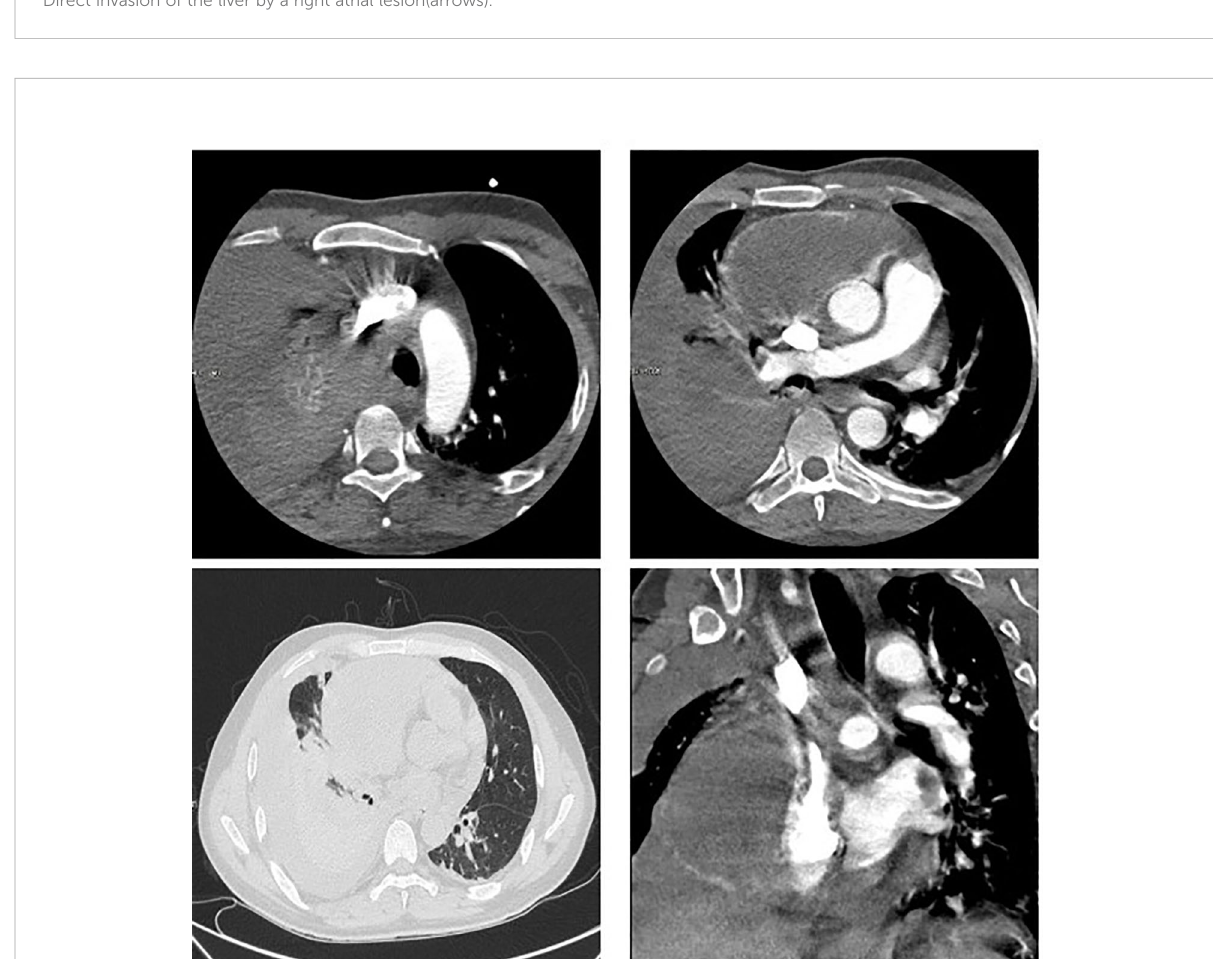
FIGURE 5 Massive pleural effusion, diagnosis of cardiac tumor rupture, but no exact bleeding point